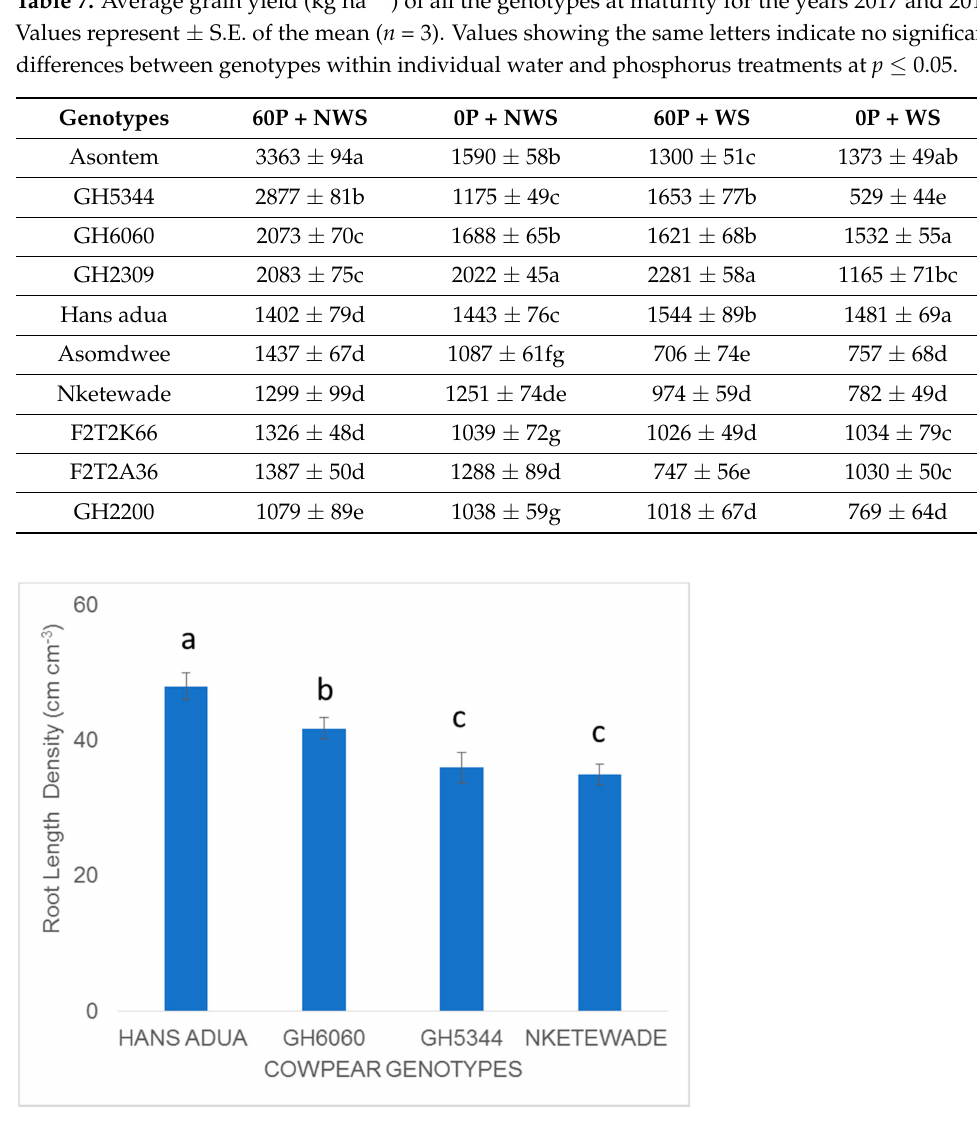
Figure 4. Comparing root length density of four genotypes subjected to P and water stress during field studies. Values are means of three replicates ( n = 3) and standard error bars. Different letters above the column indicate statistical significance at the p < 0.05 level within the same measurement stage. Bars showing the same letters indicate no significant differences between genotype treatments at p <